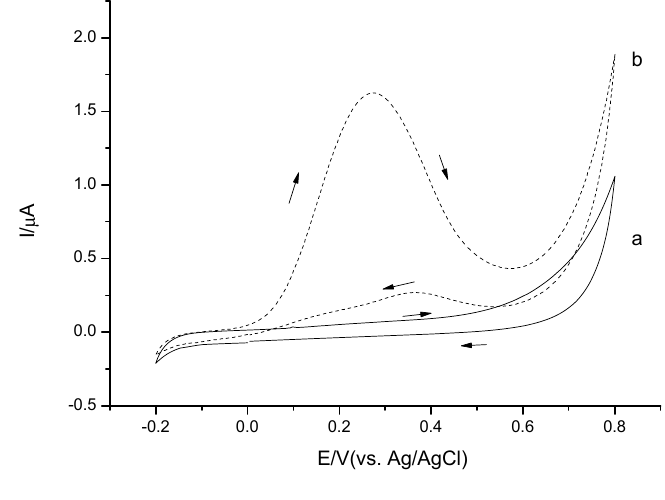
O (b). Scan rate 20 mV·s − 1 2 2